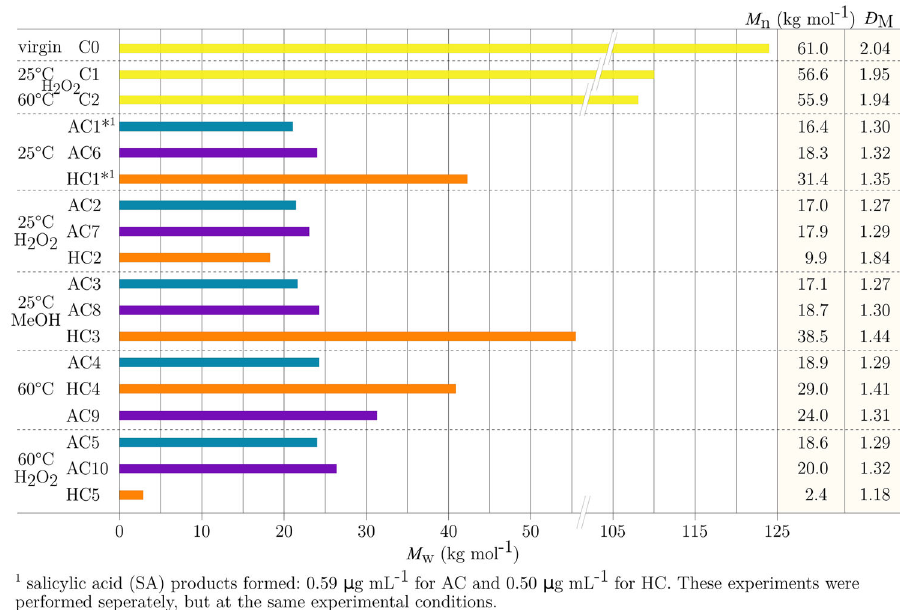
Fig. 1 Molar mass characteristics ( M w , M n , Đ M ) of PVOH after 30 min treatment with AC or HC cavitation under different experimental conditions (PVOH concentration, temperature, H 2 O 2 or MeOH addition). Yellow color bars represent M w of non-cavitated virgin and control samples; blue and violet color bars represent M w after AC treatment of PVOH solutions with two concentrations: 1 and 2 g L − 1 , respectively; and orange color bars represent M w after HC treatment of PVOH solutions with a concentration of 1 g L − 1 . Right columns show the corresponding M n and Đ M values.